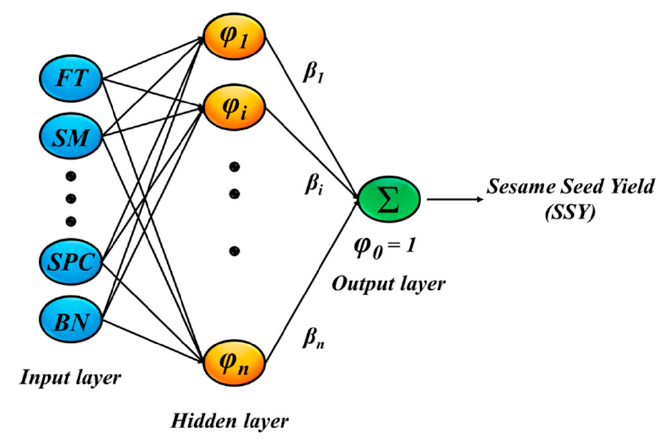
Figure 3. The RBF neural network structure applied in the present study.